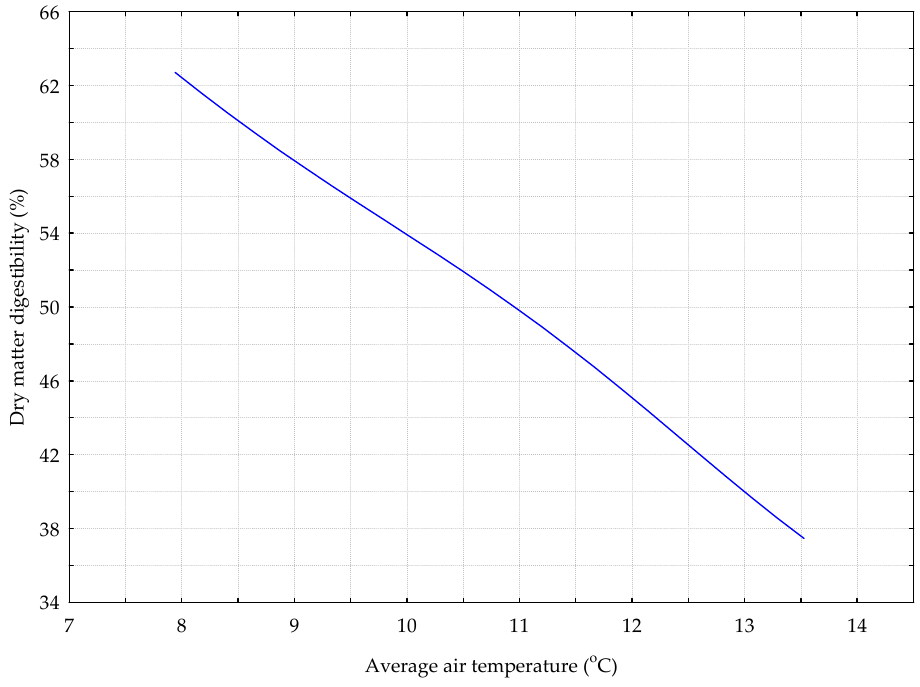
Figure 5. The DIG_G model. The response chart for variables T_AV (rank 1) and %_DMD. As the average daily air temperature increased, so did the yield of protein from the grass sward (Figure 6).